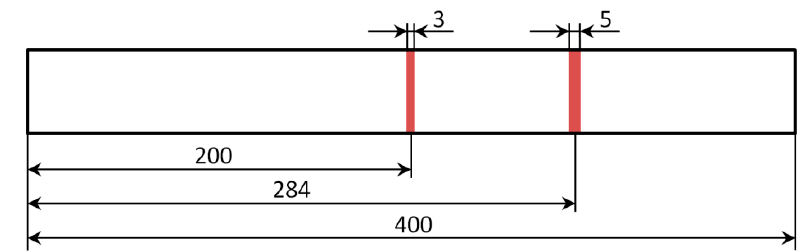
Figure 1. The two-node Euler-Bernoulli finite element marked displacements, 𝑤 (cid:2869) and 𝑤 (cid:2870) , and rotations, 𝜃 (cid:2869) and 𝜃 (cid:2870) .